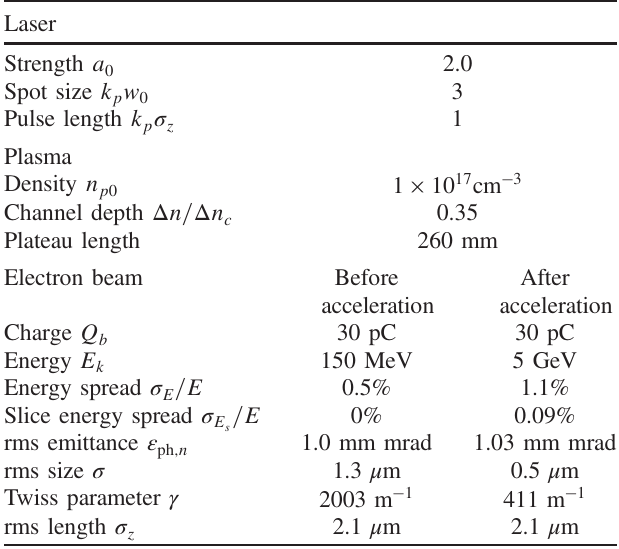
TABLE II. Main parameters of the plasma acceleration section.